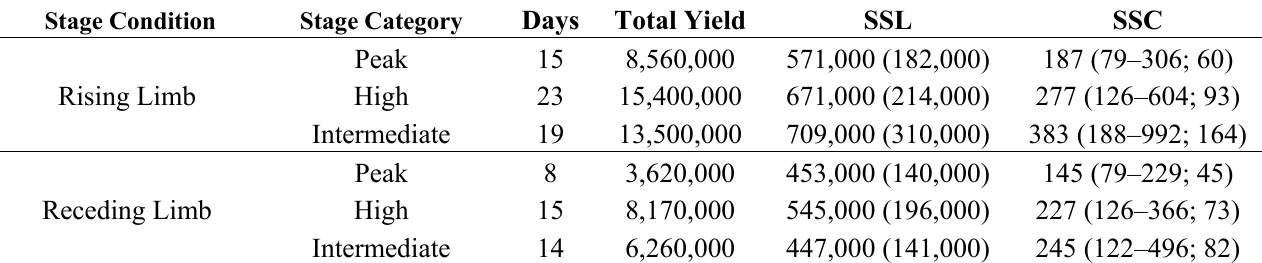
Table 4. Sediment concentration and load on the rising and receding limbs of the flood hydrograph for different stage categories a